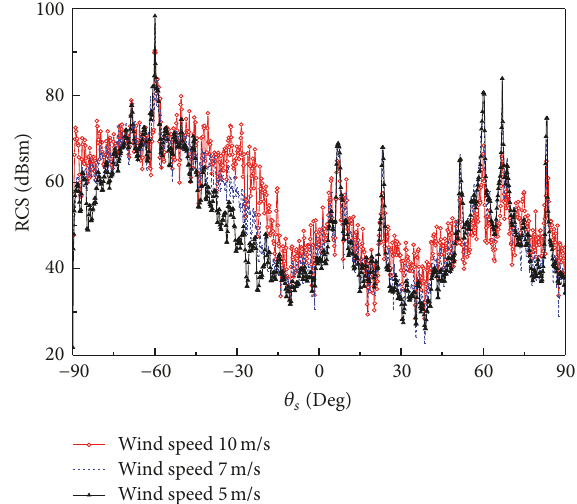
Figure 15: Bistatic RCS results for HH-polarization of the ship- ocean model at different wind